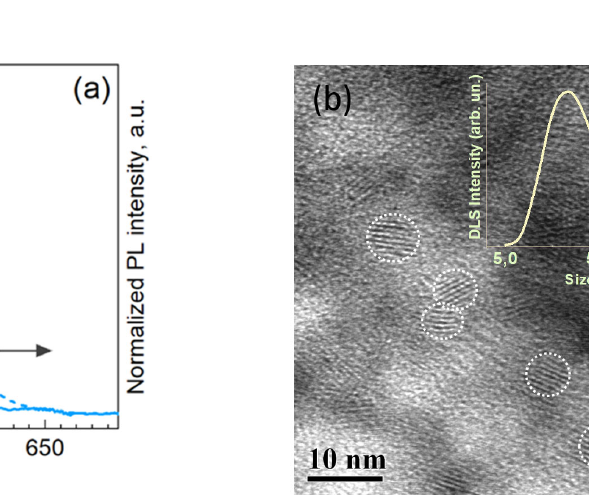
Figure 1. Optical absorption (solid line) and PL (dashed line) spectra ( a ) and a representative TEM image ( b ) of the CdTe ‐ TGA NCs. The inset shows the DLS data on the NC size measured in the solution.